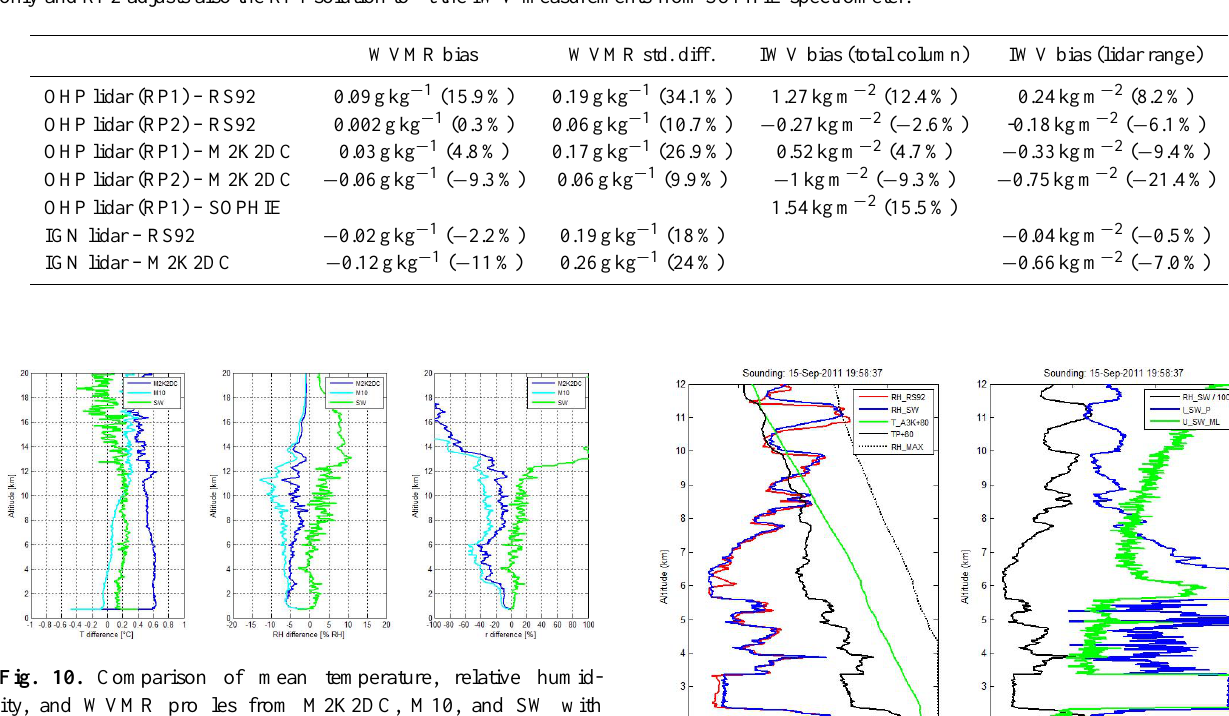
Table 4. Results of comparison of WVMR measurement between NDACC-OHP lidar, IGN-LATMOS lidar, and radiosondes (RS92 and M2K2DC) on 21 October 2011 around balloon launch time, 20:24UTC (see Fig. 7). WVMR bias and standard deviation of difference (std. diff.) are computed over a single profile. Two IWV solutions are compared for the OHP lidar: total column (reconstructed profile using RS + lidar + climate, see Fig. 3) and lidar range (2–8km altitudes). For the IGN lidar, only one IWV comparison is reported over the lidar range (0.85–6.0km altitudes). RP1 and RP2 refer to two profile reconstruction methods for the OHP lidar: RP1 uses Nîmes radiosonde data only and RP2 adjusts also the RP1 solution to fit the IWV measurements from SOPHIE spectrometer.